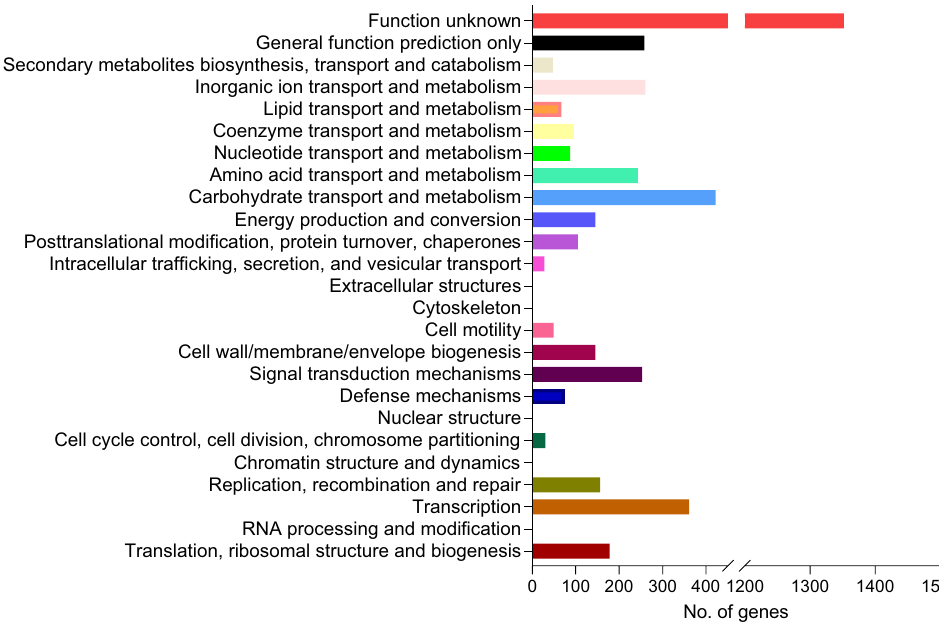
Fig. 2 The cluster of orthologous groups (COG) classification of putative proteins in the ATSA2 T